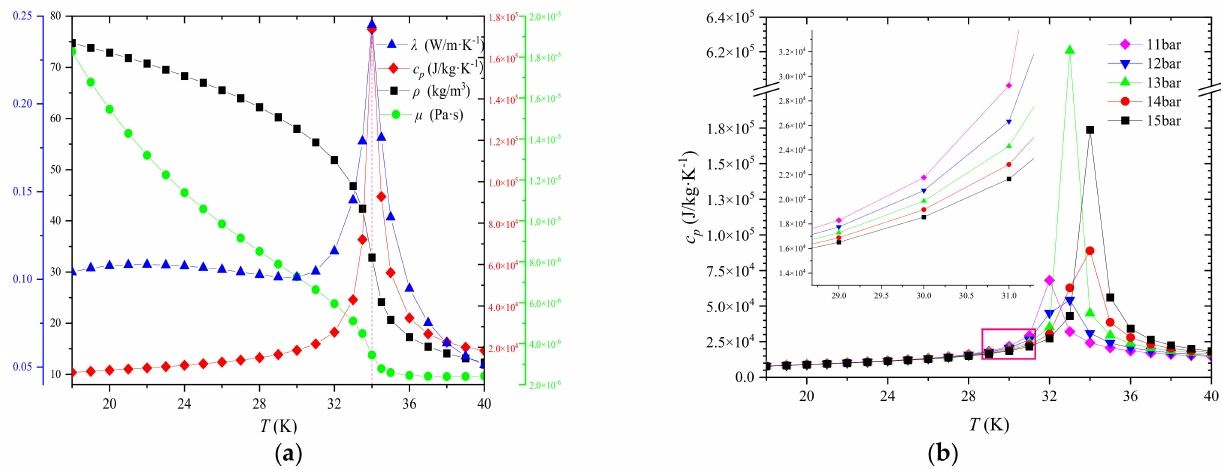
Figure 4. Variations of thermophysical properties of liquid hydrogen under different pressure: ( a ) Pressure = 15 bar; ( b ) Specific Heat (different